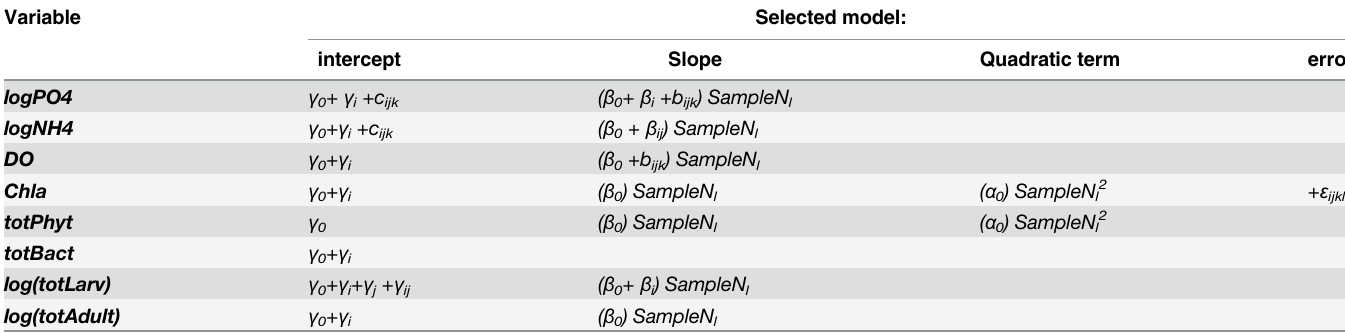
Table 2. Selected statistical models for the univariate response